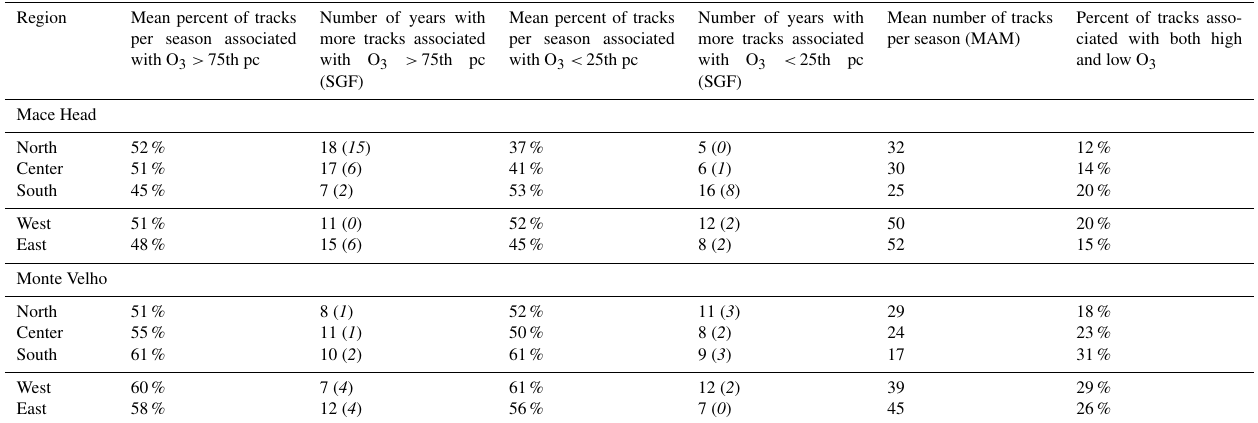
Table 2. The mean percent of cyclone tracks associated with high O 3 ( > 75th pc) and low O 3 ( < 25th pc) measured at the surface at (top) Mace Head based on each MAM season in the period 1988–2010 and (bottom) Monte Velho based on each MAM season in the period 1989–2009 (excluding 1999 and 2005, which had insufficient data). The total number of years in the (top) 23-year period (1988–2010) and (bottom) 19-year period (1989–2009, excluding 1999 and 2005) which have a greater number of tracks associated with O 3 > 75th pc and O 3 < 25th pc is also given. The total number of those years which have a significant χ 2 difference at p < 0 . 05 confidence interval is given in the brackets (SGF). See Sect. 3.1.1 for definition of